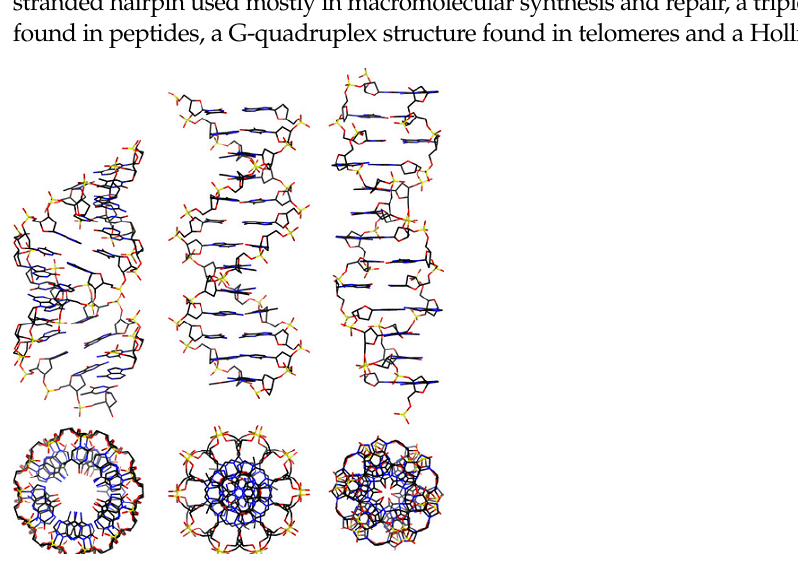
Figure 1. From left to right, the structures of A-, B- and Z-DNA. The view of the double helix from above (or below) shows distinct symmetries, 11-fold for the A-DNA, 10-fold for the B-DNA and 6-fold for the Z-DNA